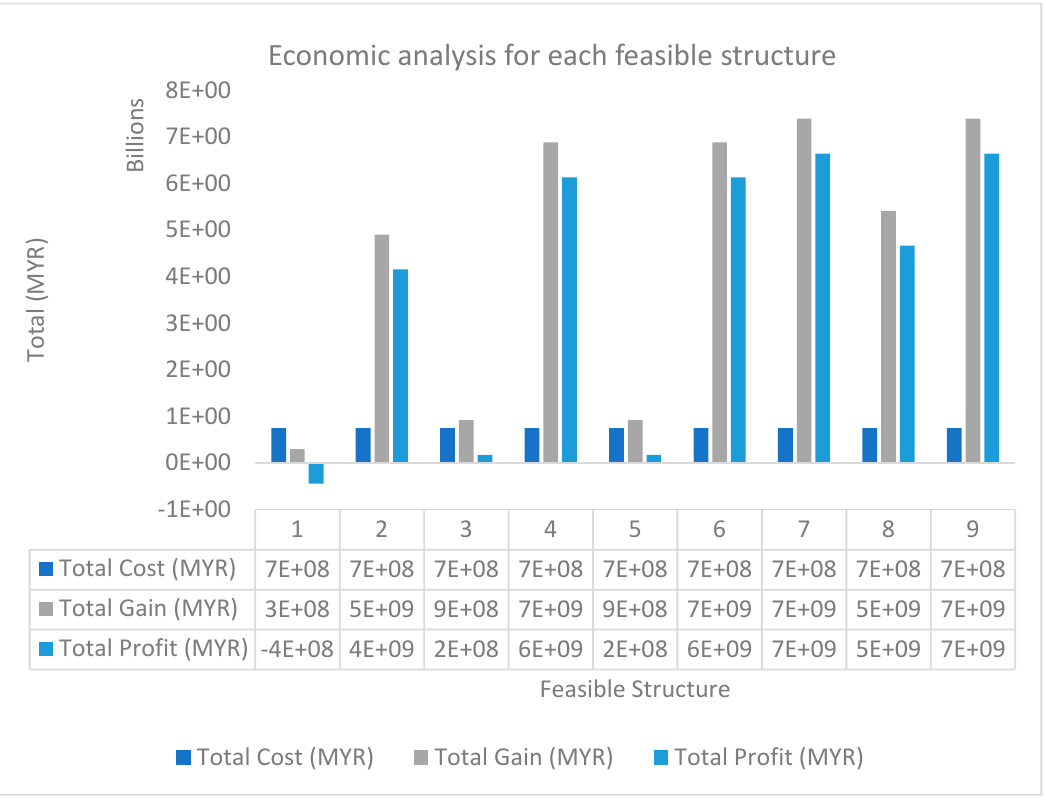
Figure 6. Economic analysis for each feasible structure. Table 6. Products generated by each feasible structure.